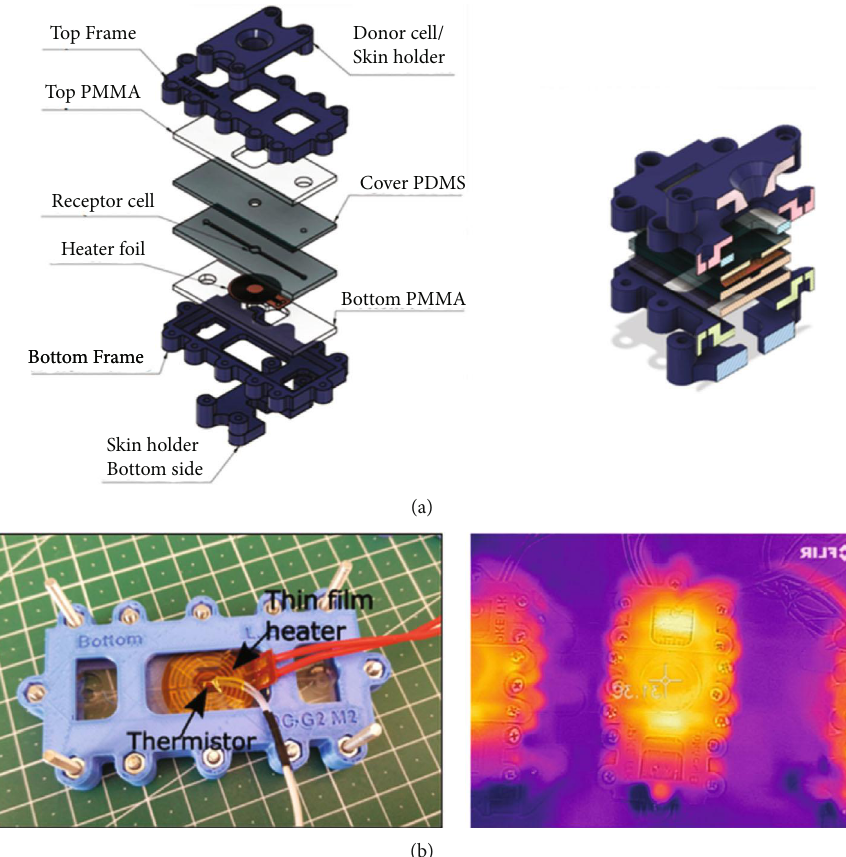
Figure 22: : Schematic view of the micro fl uidic di ff usion chamber. (a) Layer by layer view. (b) The bottom side of the chip and temperature control measurement. Reproduced (or adapted) with permission [116], ©2018, MDPI.